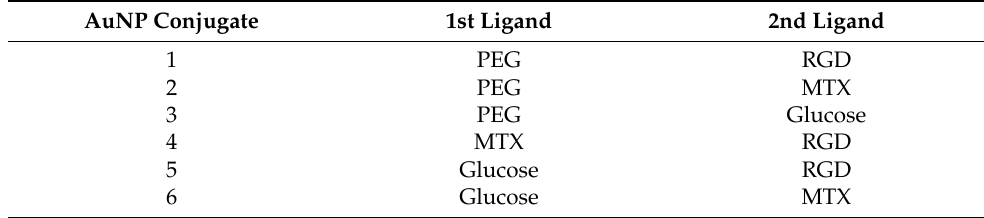
Table 1. Summary of gold nanoparticle conjugates.